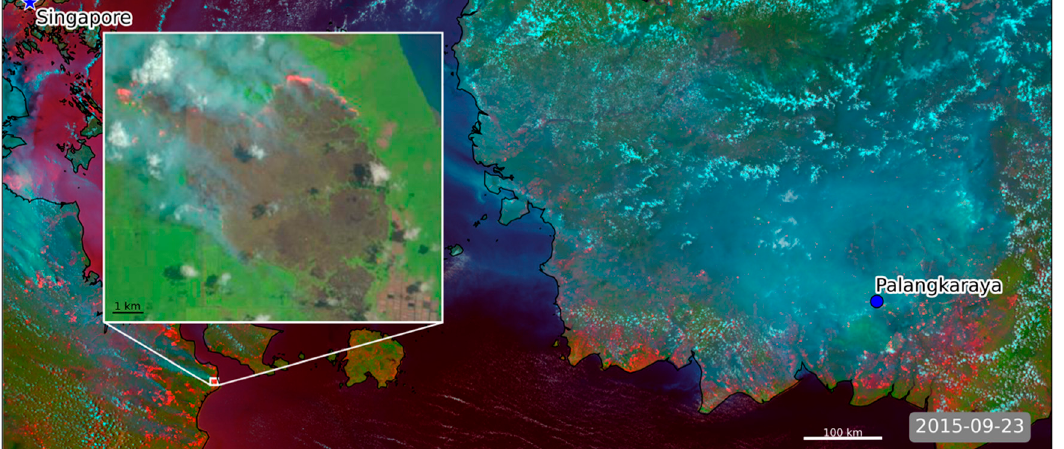
Figure 1. Satellite imagery of Kalimantan and South Sumatra taken on 23 September 2015 during the extreme landscape fires exacerbated by the strong El Niño-related drought. Main image: Visible Infrared Imaging Radiometer Suite (VIIRS) false colour composite (R: 3.7 µm; G: 0.865 µm; B: 0.488 µm) where clouds appear white, smoke blue—grey, and actively burning fires—bright red. Inset image: Landsat false colour composite (R: B6 (SWIR); G: B5 (NIR); B: B4 (VIS)) for the same day as the main image, focused on the longest of the Sumatran plumes present in the main image whose source region is boxed in white on the VIIRS imagery. Again, clouds appear white, smoke grey, and actively burning fires orange/red; also note the large burned area, which appears dark brown. The fire shown in the Landsat scene is plume/fire matchup Fire 7 in Figure 2.